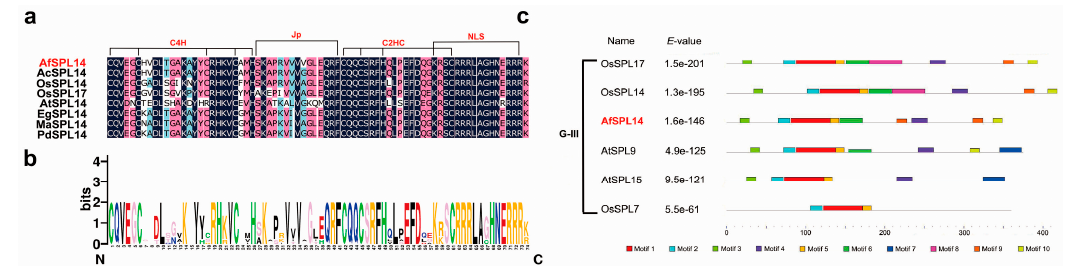
Figure 2. Sequence alignment and logo view of variable SBP domains, and putative motifs of variable SPLs in group III. ( a ) Multiple alignment of the SBP domains using DNAMAN software. The four conserved motifs, which include two zinc finger-like structures (C4H, C2HC), Jp and NLS, are indicated; ( b ) Sequence logo view of the consensus SBP domains. The overall height of the stack and the height of each letter represent the sequence conservation at that position and the relative frequency of the corresponding amino acid at that position, respectively; ( c ) putative motifs of variable SPLs in group III identified by MEME software online (http://meme-suite.org/tools/meme). The color boxes represent different putative motifs for which the sequences are listed in Table S2 online. G-III indicates group III from Figure